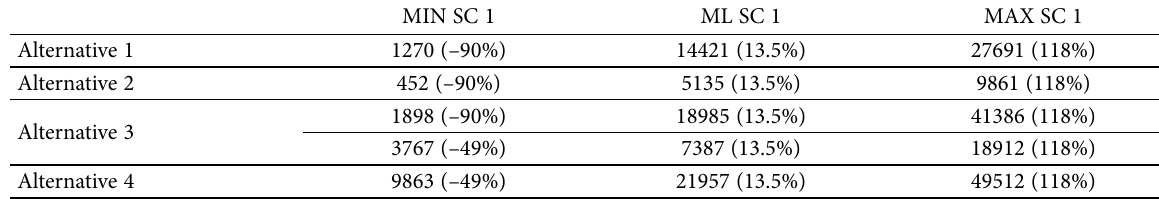
Table 10. Scenario 1 TTS-TR parameters to the Beta-PERT distribution [mDKK]